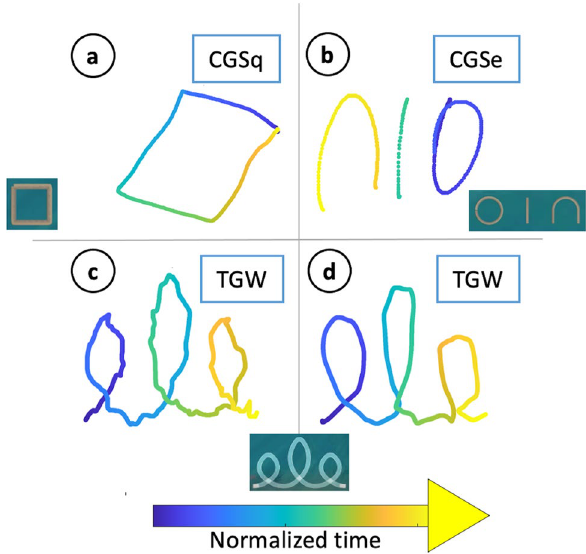
Figure 4. Examples of executions from NR children that achieved a high O-score. Color represents time progression. Templates are reported for reference.